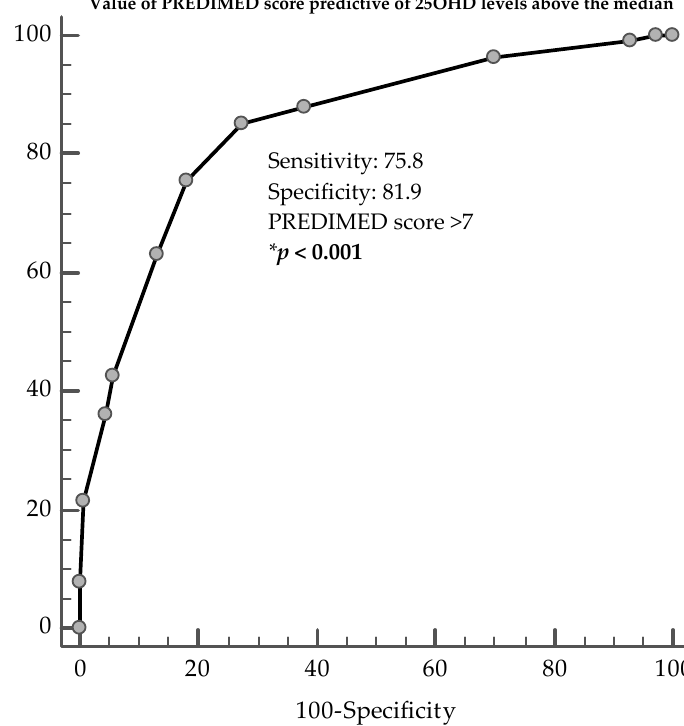
Figure 4. ROC for value of PREDIMED score predictive of 25OHD levels above the median, in females. * A p -value in bold type denotes a significant difference ( p < 0.05).